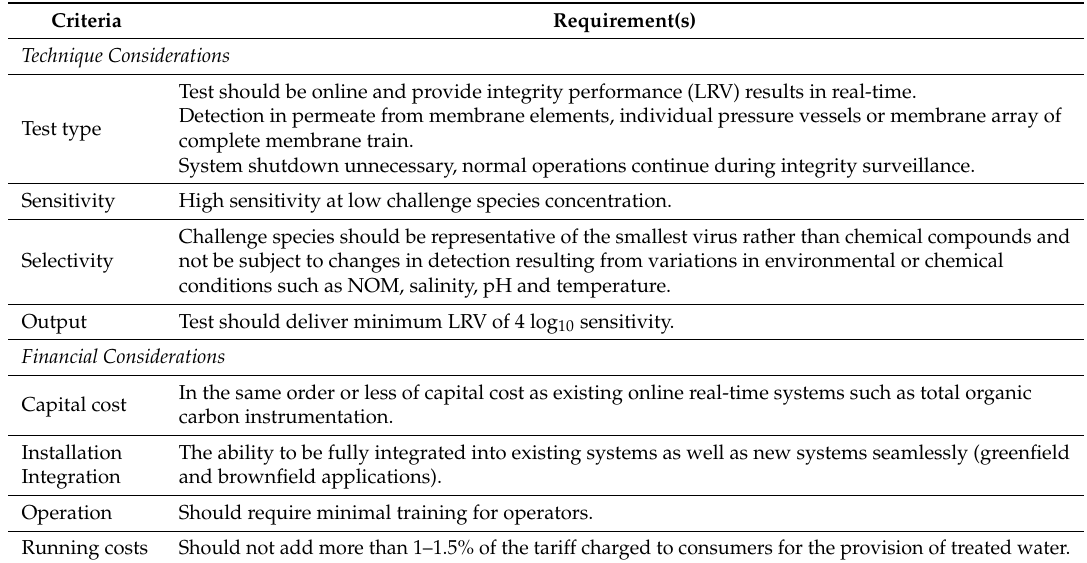
Table 1. Suggested criteria for ideal integrity monitoring systems or